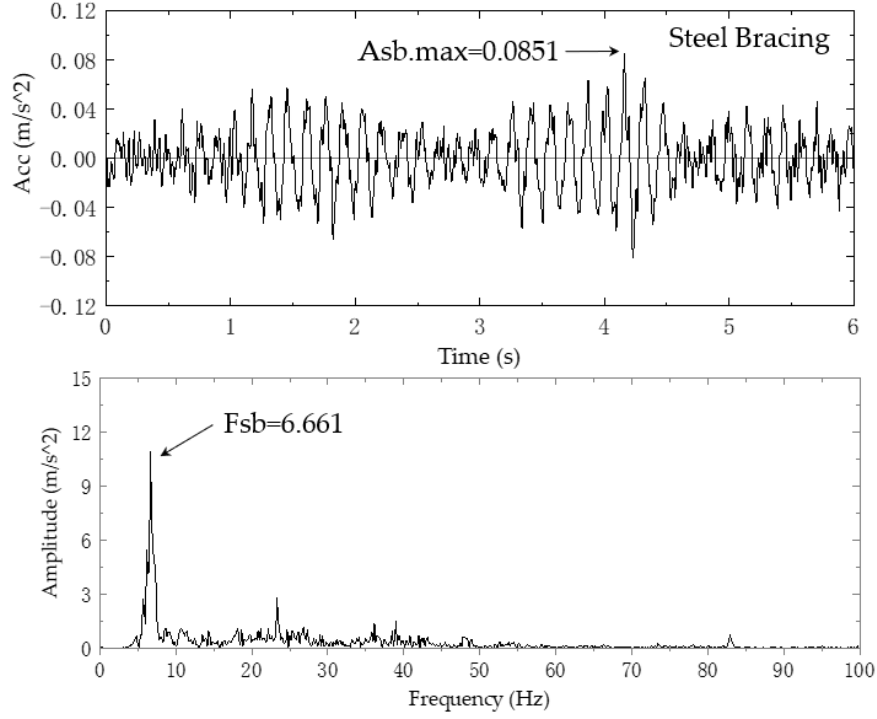
Figure 13. Vibration response of steel assembly bracing.